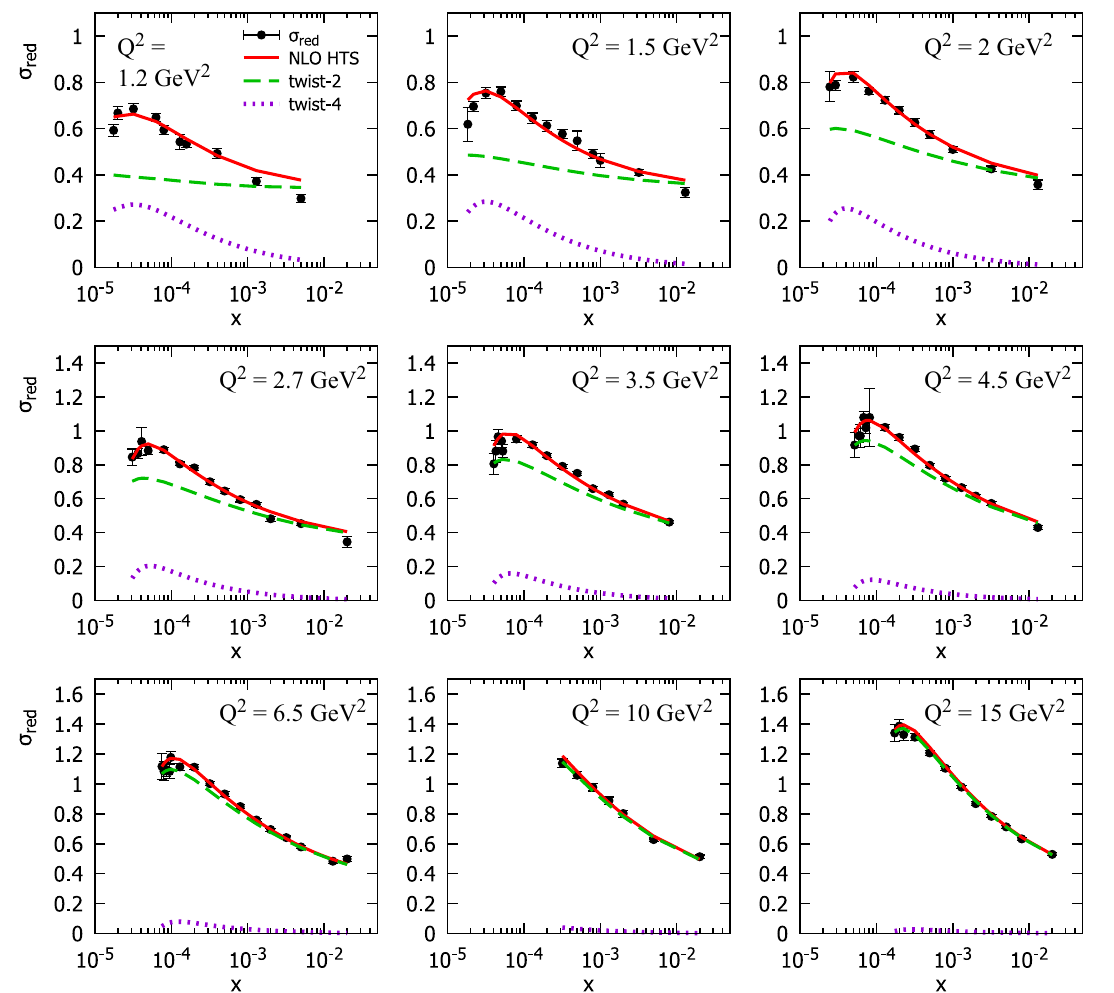
Fig. 4 The combined low- Q 2 HERA inclusive NC e + p reduced cross sections compared to the NLO HTS fits (full red line). Also shown twist 2 (dashed green line) and twist 4 (dotted purple line)